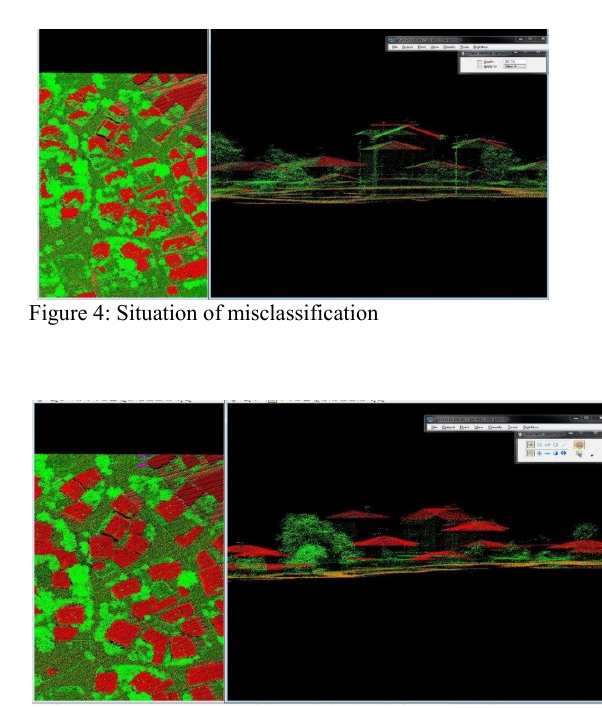
Figure 5: Corrected buildings and vegetation after manual